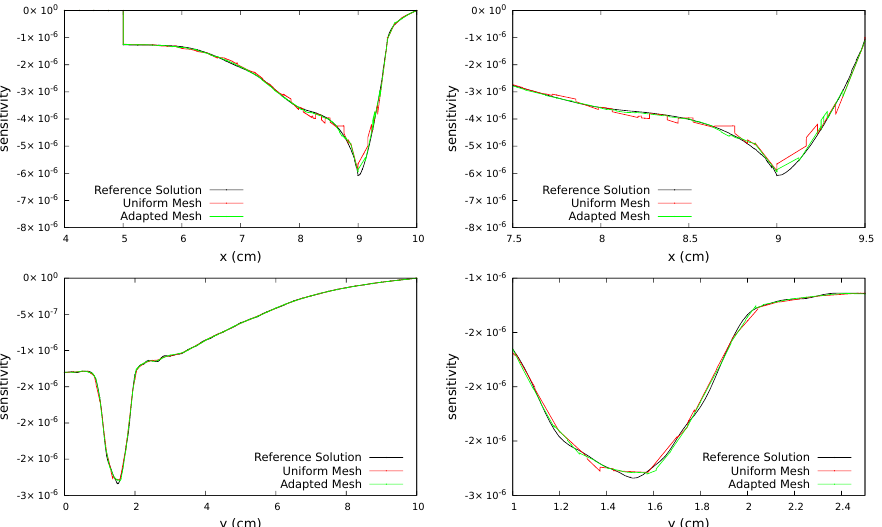
Figure 5. Sensitivity with respect to Σ t measured along lines ( 0,2 ) – ( 10,2 ) ( top ) and ( 6,0 ) – ( 6,10 ) ( bottom ) using meshes of approximately 6 thousand elements.